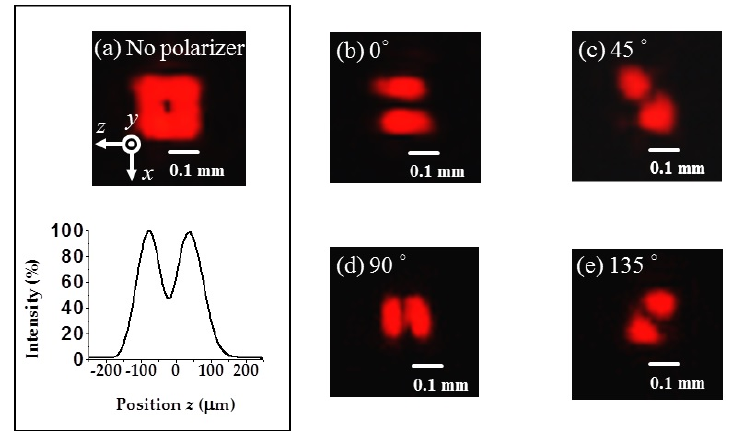
Figure 3. Azimuthally polarized lights in the reflection output converted from a linearly polarized light: ( a ) donut ‐ shaped beam profile and intensity distribution in the z ‐ direction observed without an analyzer, and beam profiles observed with the transmitting axis of an analyzer at ( b ) 0°; ( c ) 45°; ( d ) 90°; and ( e ) 135° with respect to the − z ‐ axis.